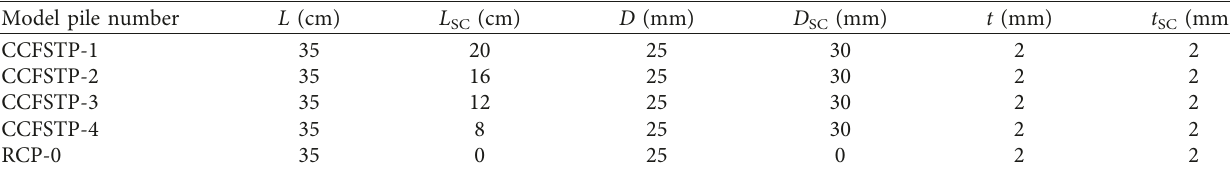
Table 1: Size of model piles.